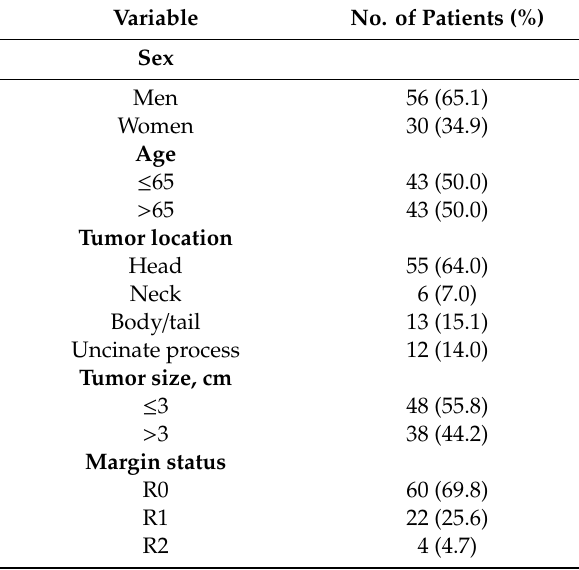
Table 2. Clinical parameters of pancreatic cancer patients in